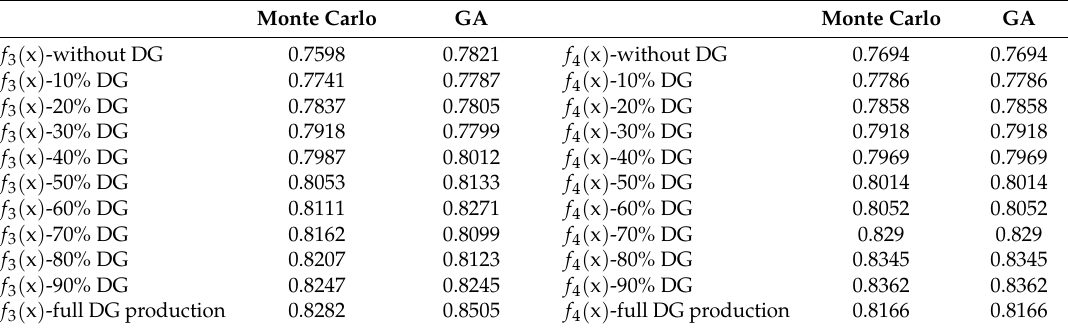
Table 8. Minimization results for f 3 ( x ) and f 4 ( x )